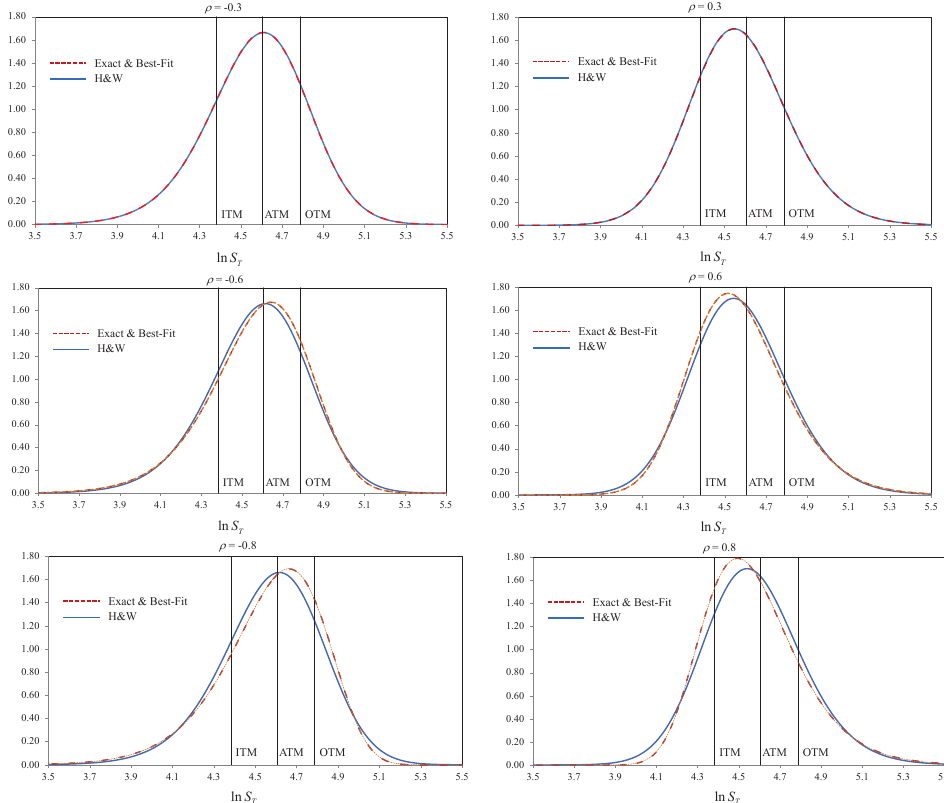
Figure 3. Illustration of the underlying distributions of ln S T